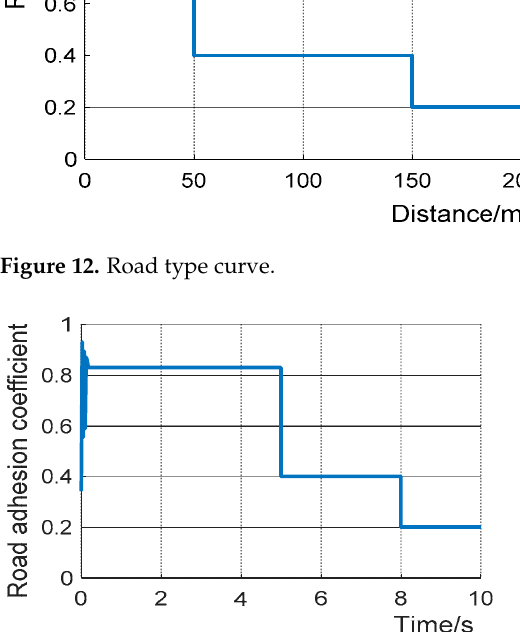
Figure 13. Road adhesion curve.